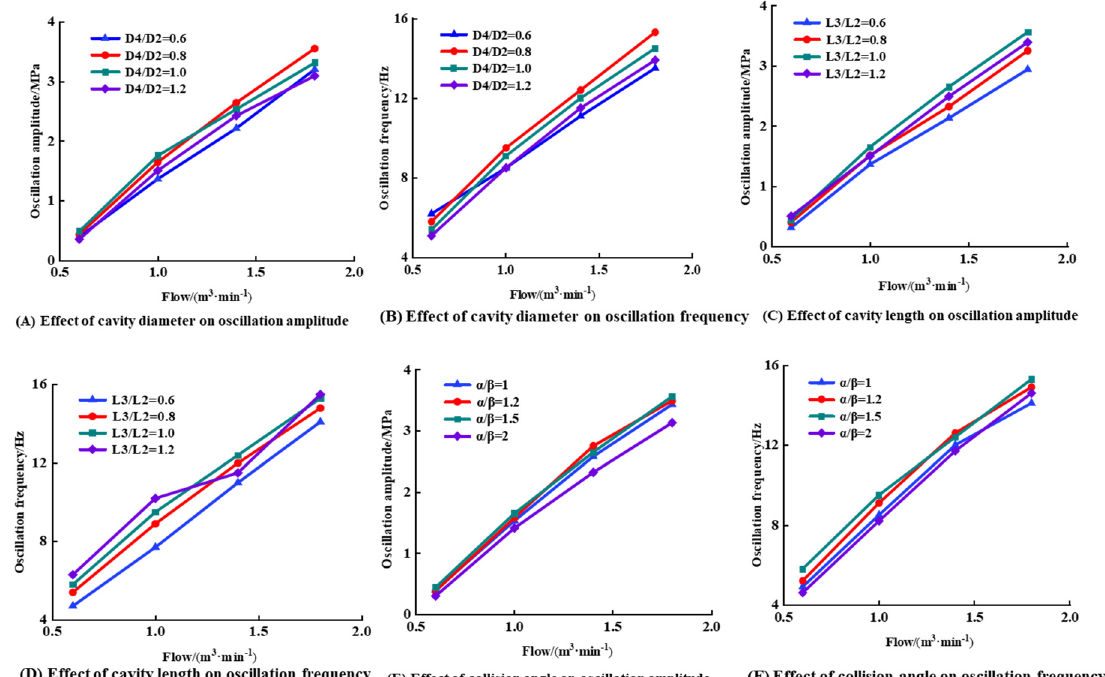
Table 2. The test parameters of the multi − source pulsed jet generator.